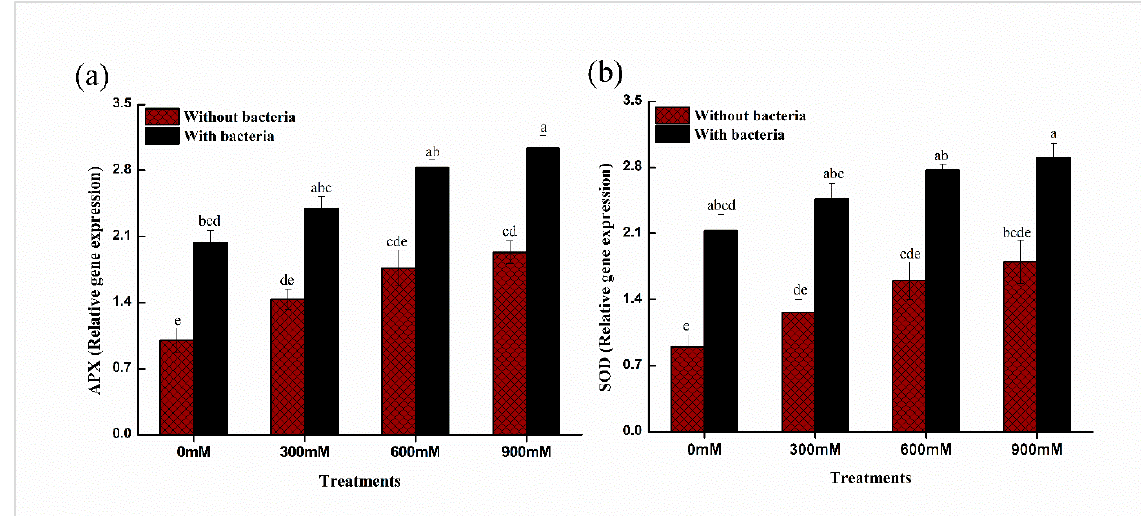
Figure 7. Expression levels of antioxidant genes of maize in the absence and presence of E. cloacae PM23 under salinity stress ( a ) Ascorbate peroxidase (APX) ( b ) Superoxide dismutase (SOD). The a, b, c, d, e inside the figure (on top of the bar graphs) refer to the same meaning in the caption.